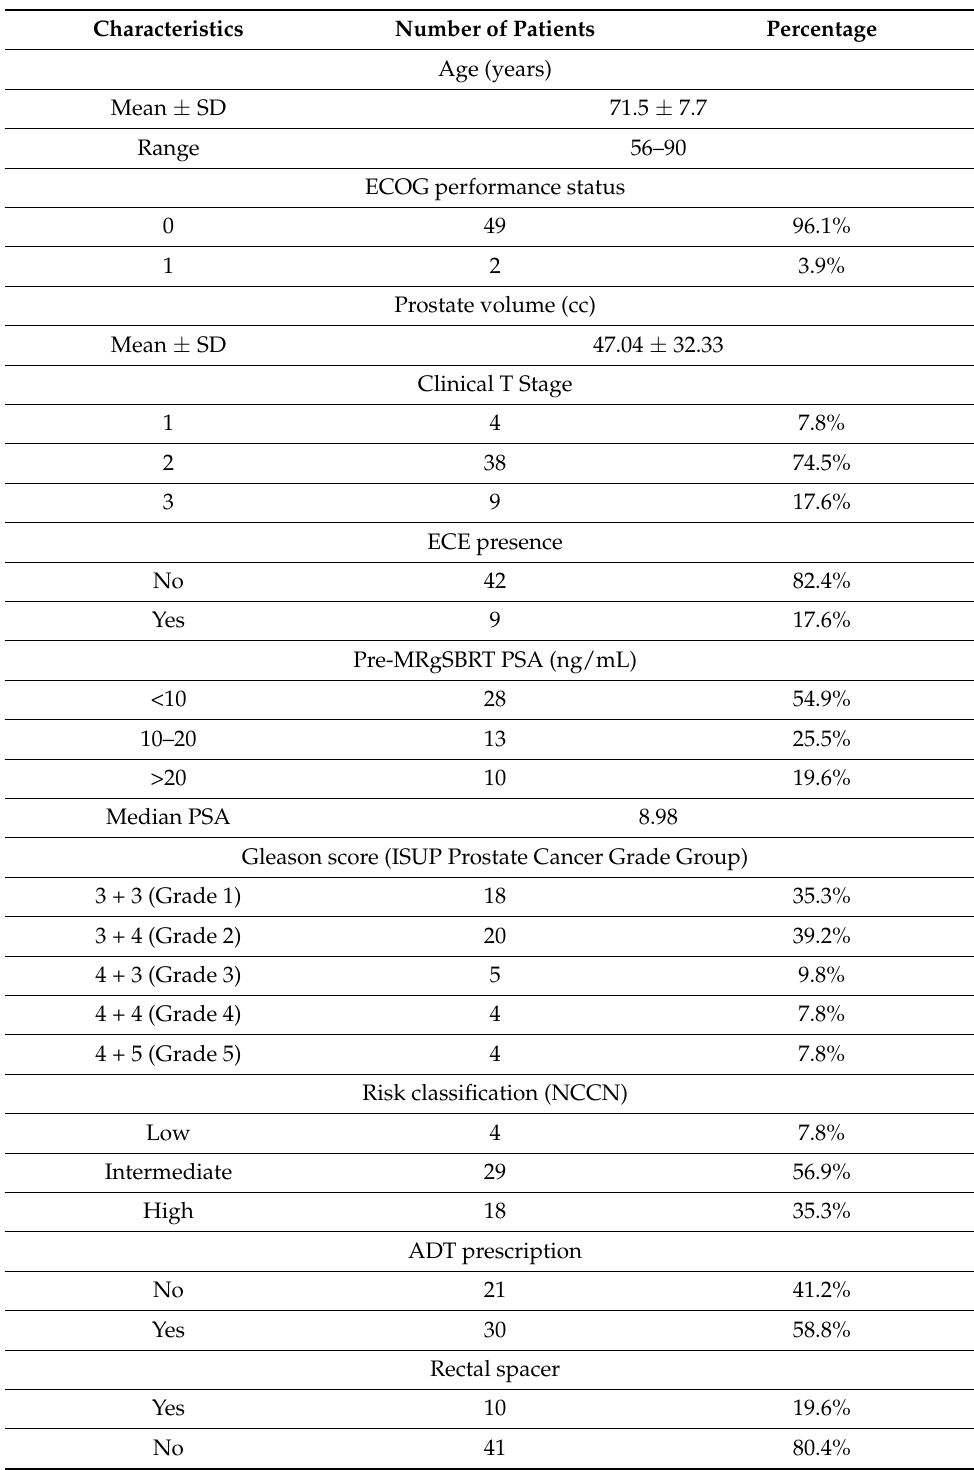
Table 1. Patient characteristics at baseline (N =